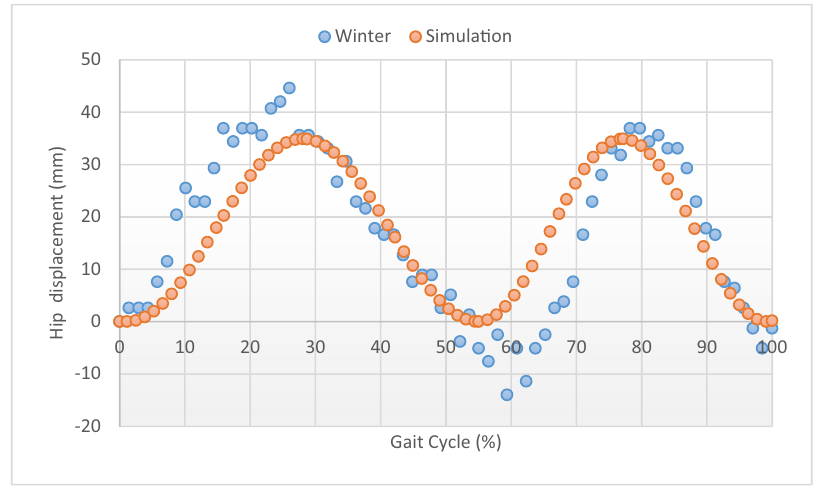
Figure 17: Variation of hip displacement during gait.